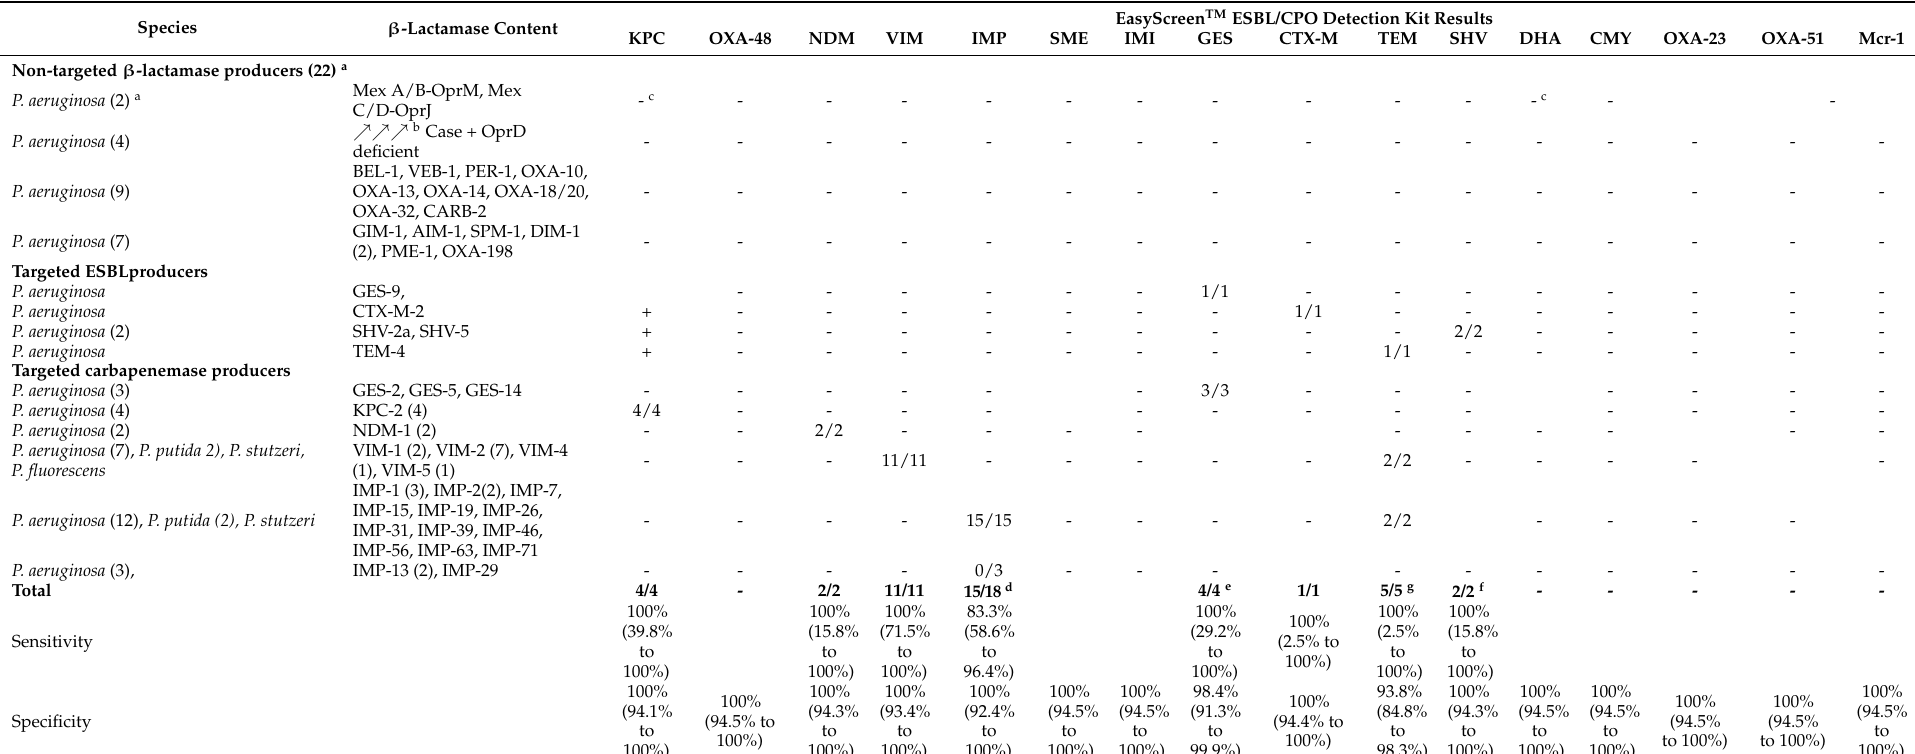
Table 3. Global performances of the EasyScreen TM ESBL/CPO Detection Kit on Pseudomonas spp. (n =